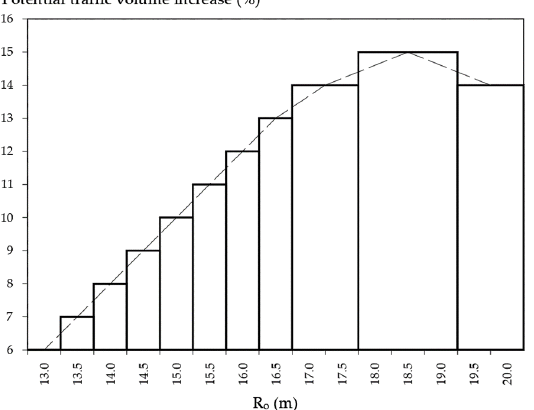
Figure 14. Results of the reversed calculation of traffic flow — the difference in traffic flow values shown as the percentage of the initial 1800 veh/h.